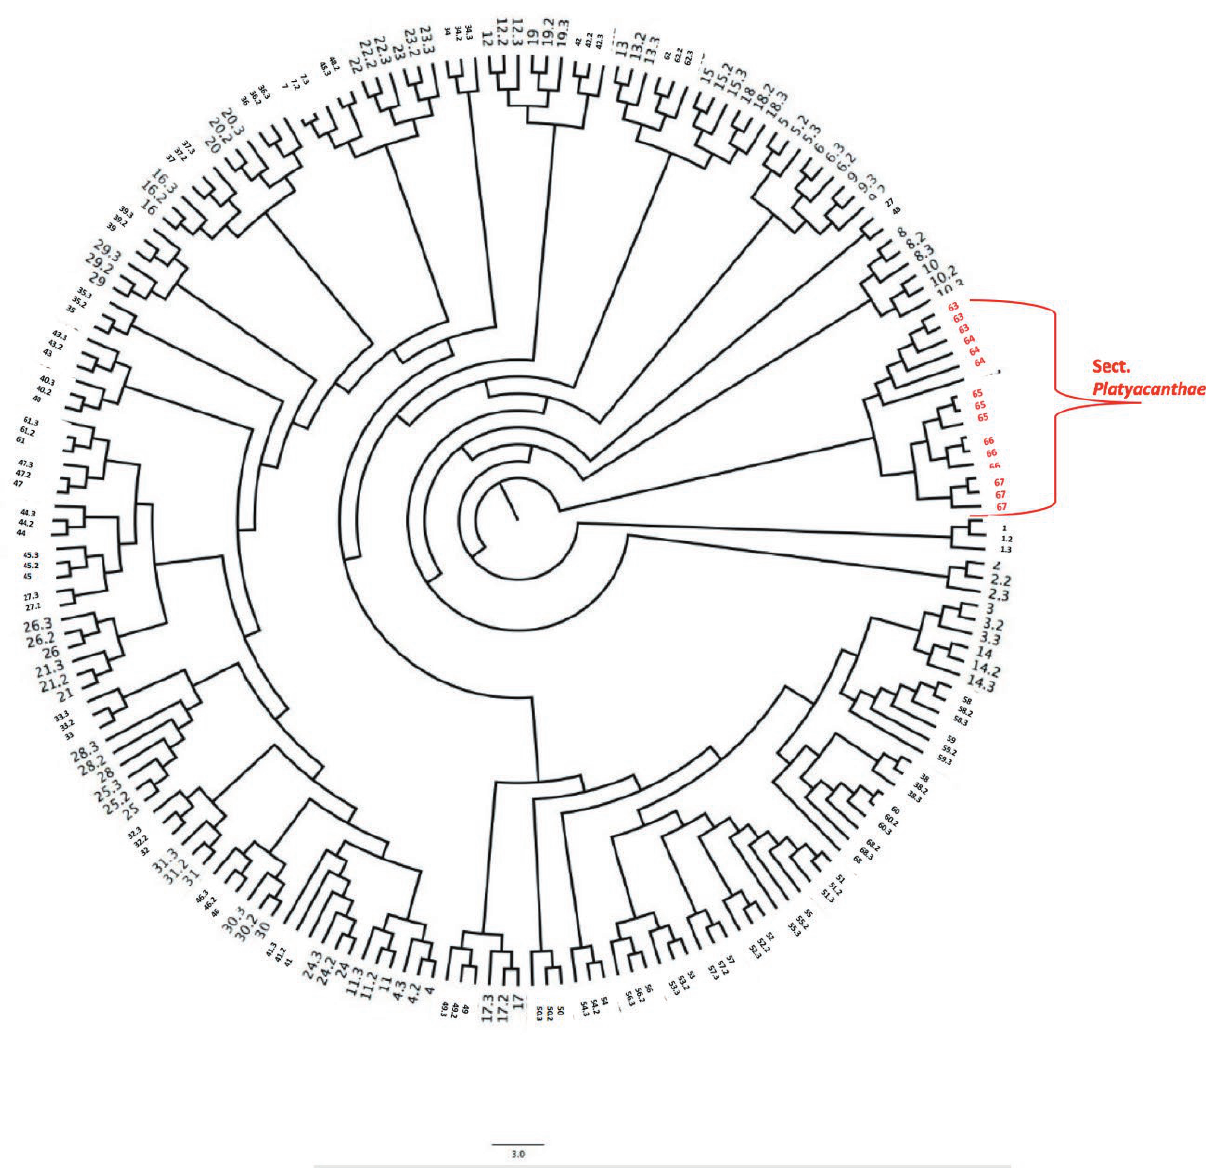
Figure 2. UPGMA dendrogram of the studied Cousinia species based on ISSR